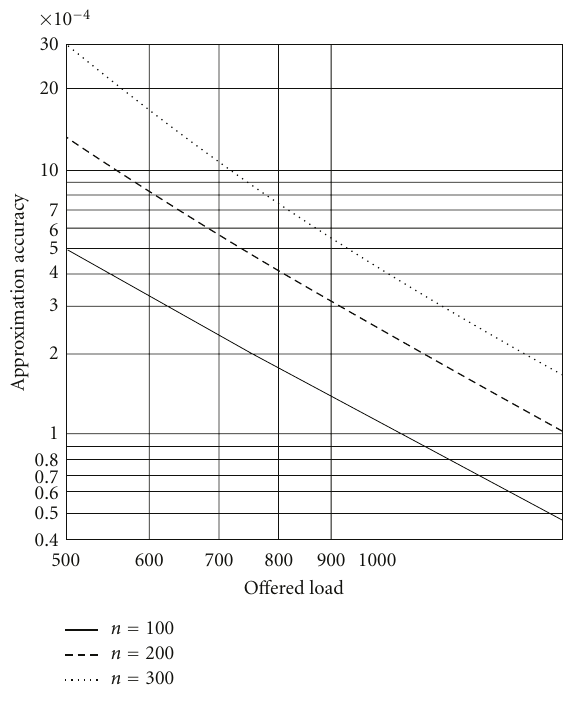
Figure 1: Approximation quality as a function of the o ff ered load.